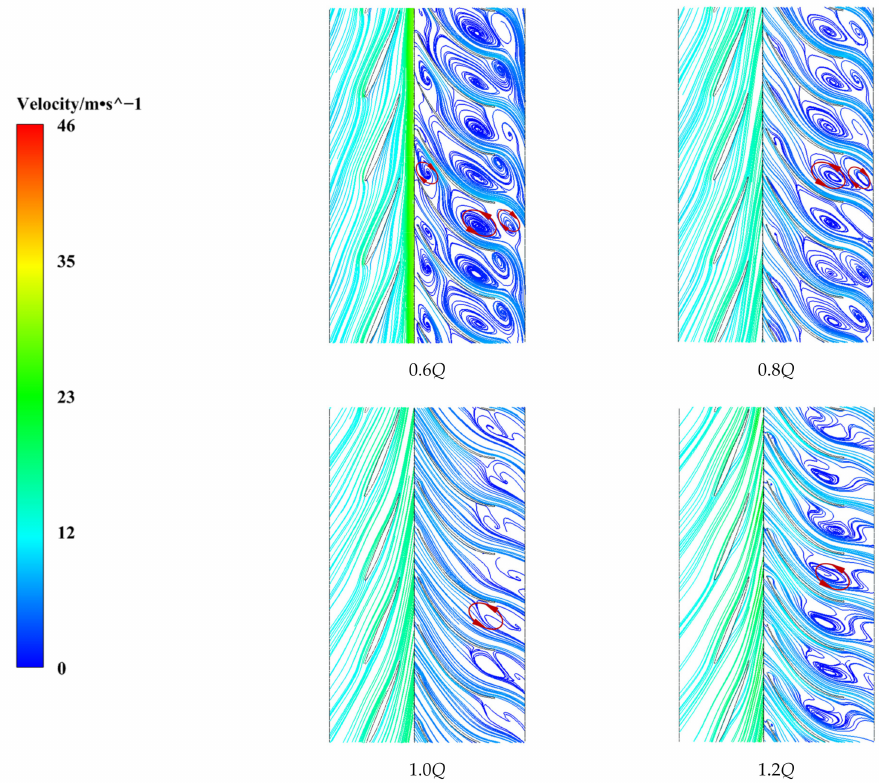
Figure 8. Streamline distributions of the unfolding surface of impeller and guide vane under different flow rate